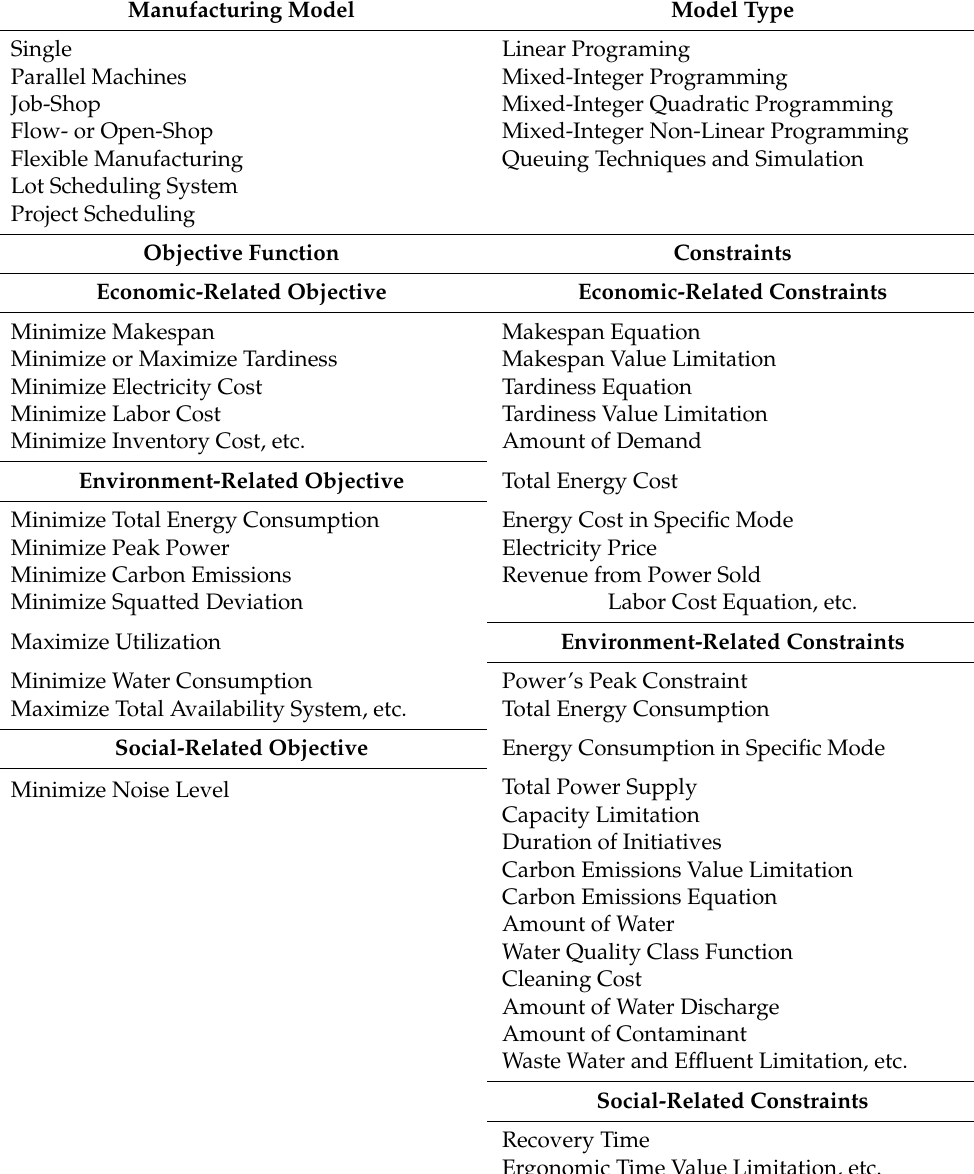
Table 1. Classification of different scheduling